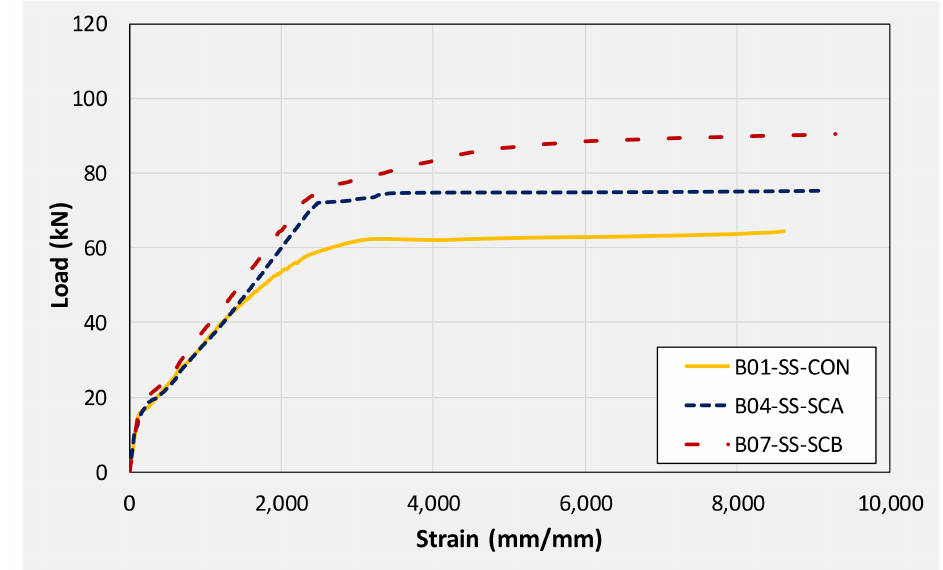
Figure 22. Monitored positive steel strain in solid section beams.